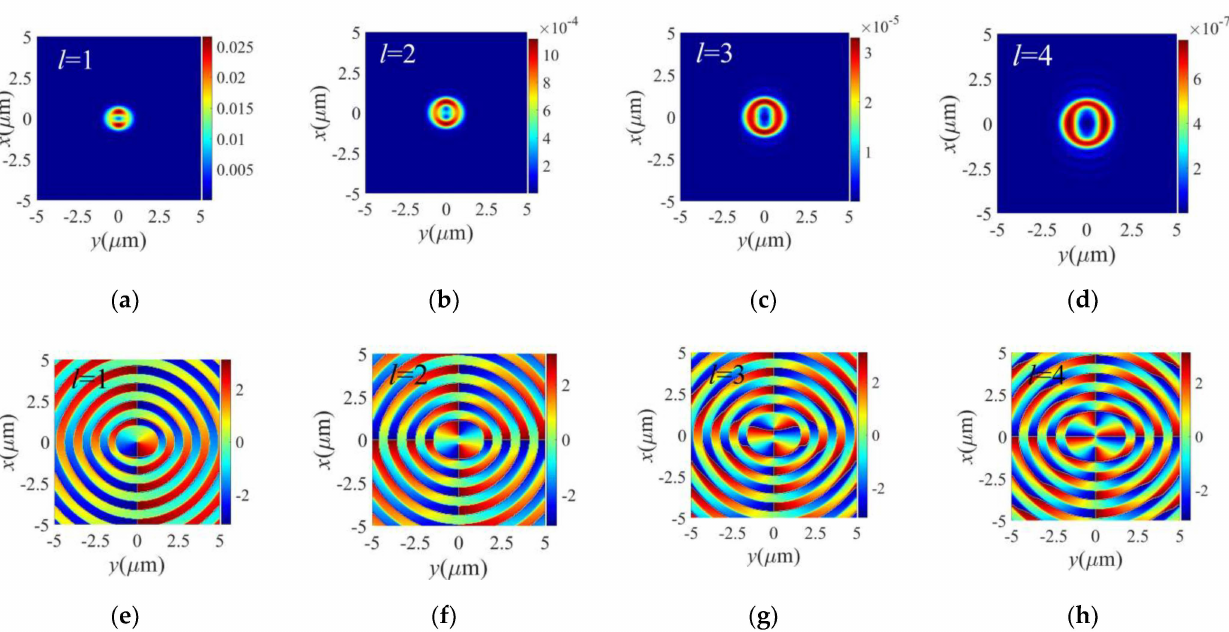
Figure 2. The intensity and phase distributions of the incident field of y-polarized Bessel–Gaussian beams with different topological charges at the source plane: panels ( a – d ); and ( e – h ) show intensity, and phase, respectively. The corresponding topological charge from left to right is